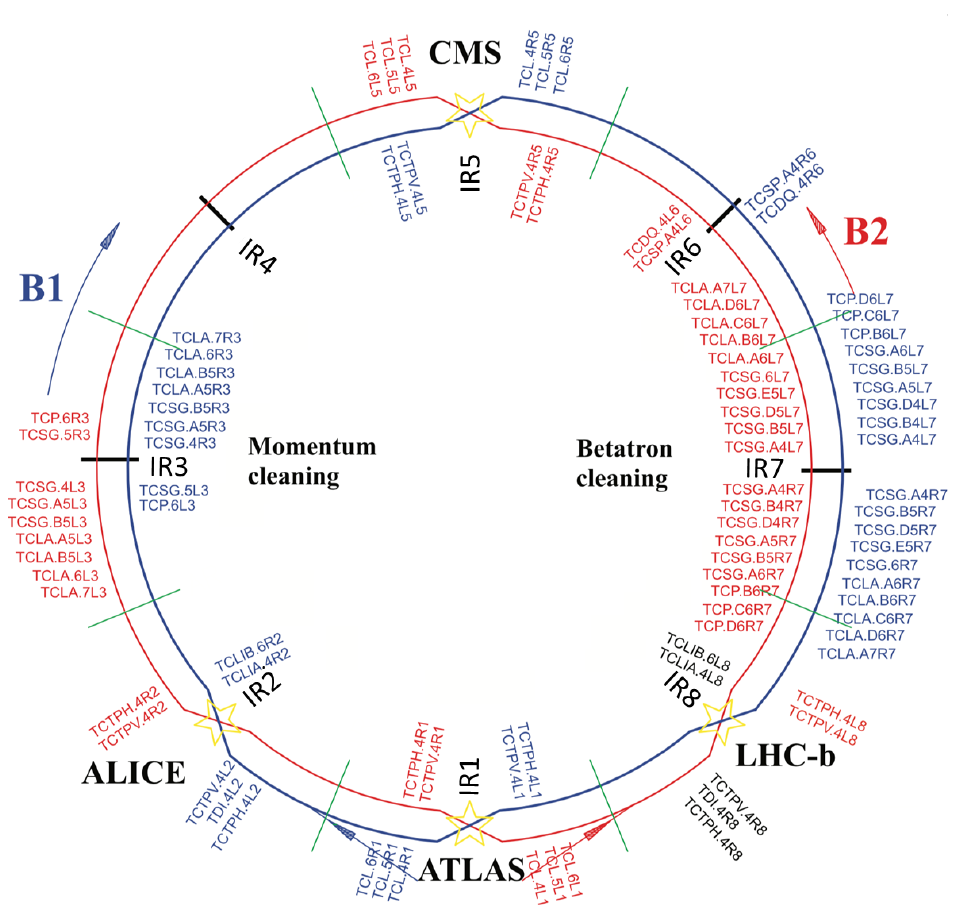
Figure 1. Schematic representation of the LHC collimation system during Run 2 (2015–2018)